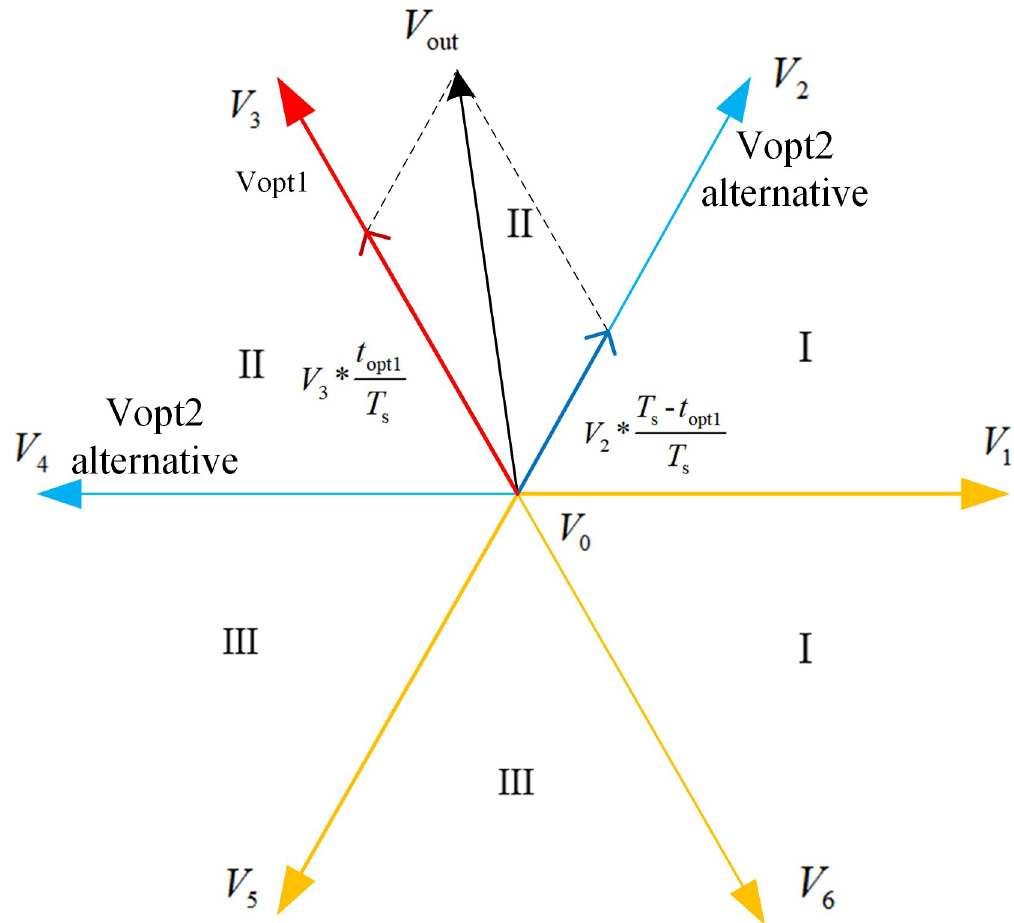
Fig 4. Schematic of the vectors in the voltage vector selection